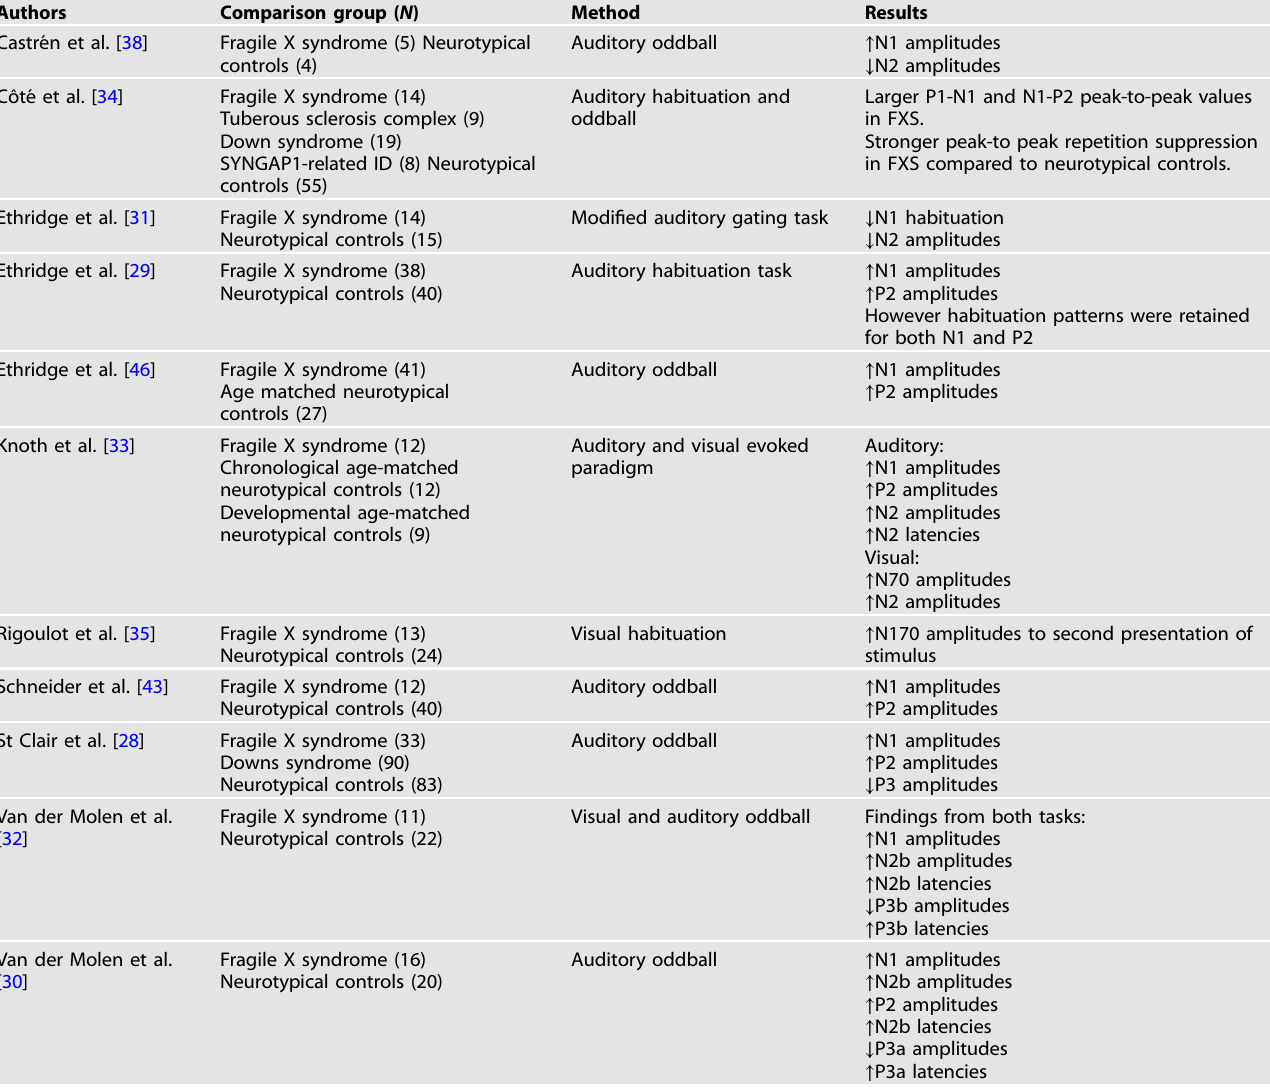
Table 1. Summary of ERP differences in humans with